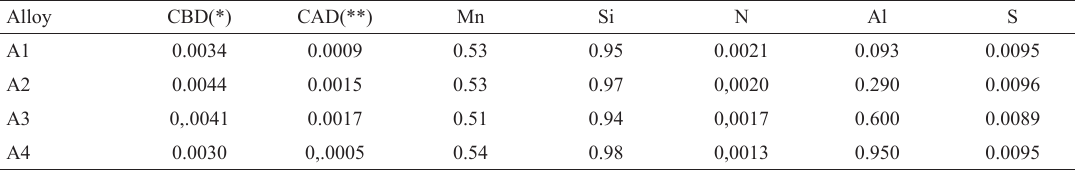
Table 1: Chemical composition (% mass).